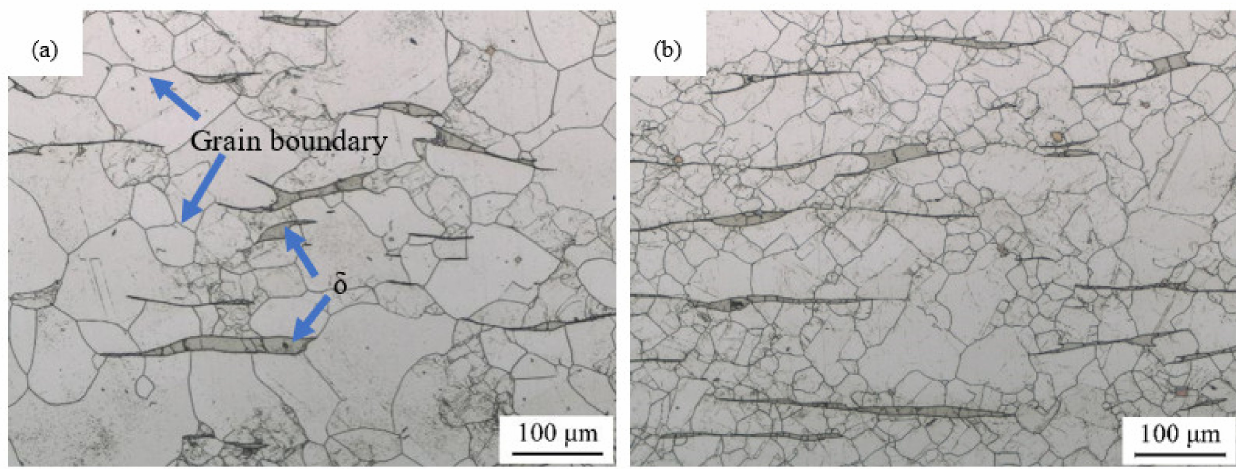
Figure 7. The microstructure at 1200 ◦ C with different strain rates: ( a ) 0.1 s − 1 ; ( b ) 10 s − 1